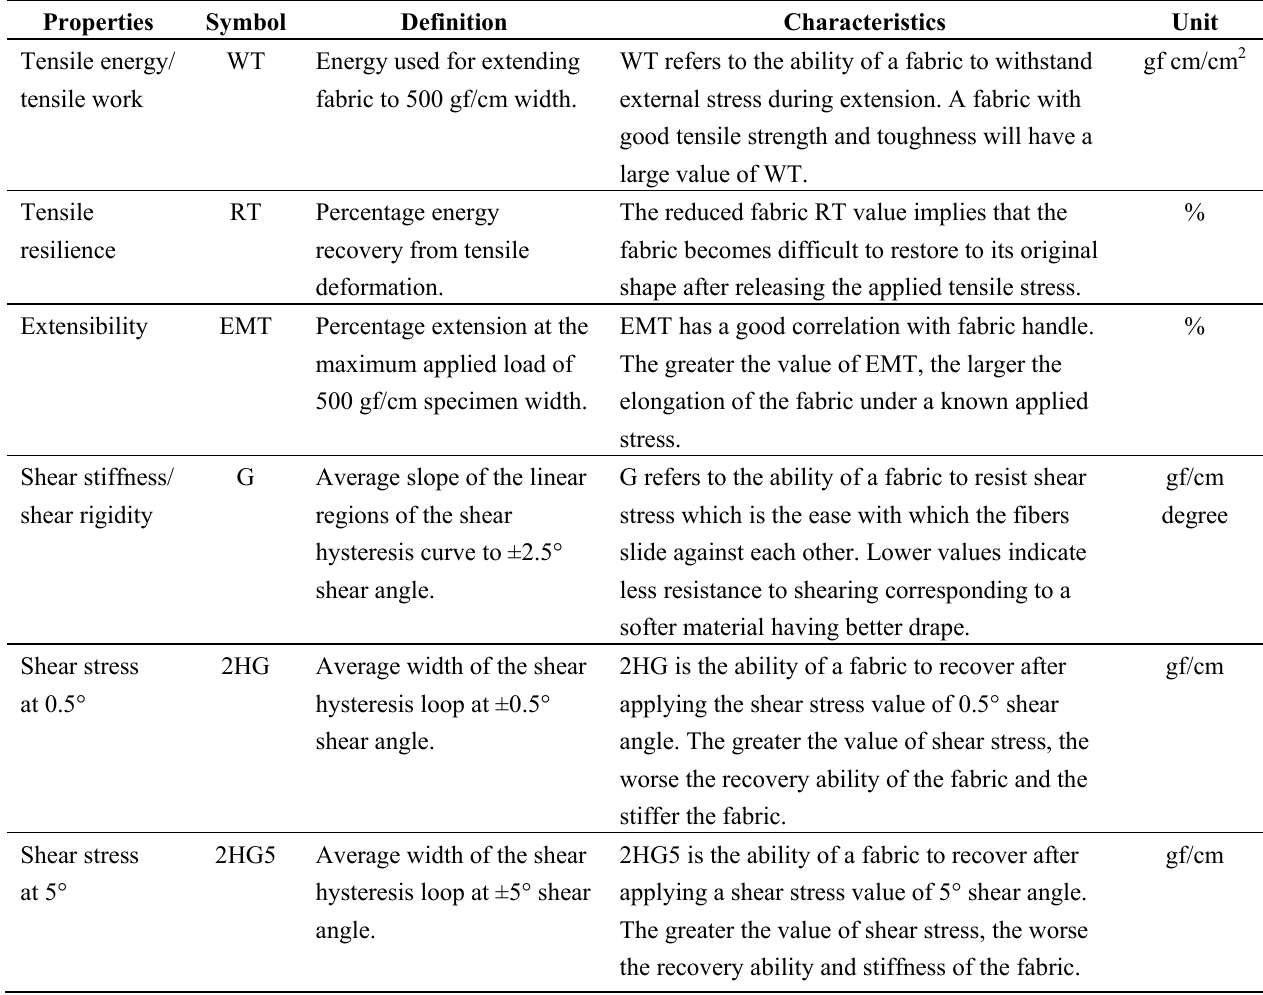
Table 2. Low stress mechanical properties obtained by the Kawabata Evaluation System for Fabric (KES-F)